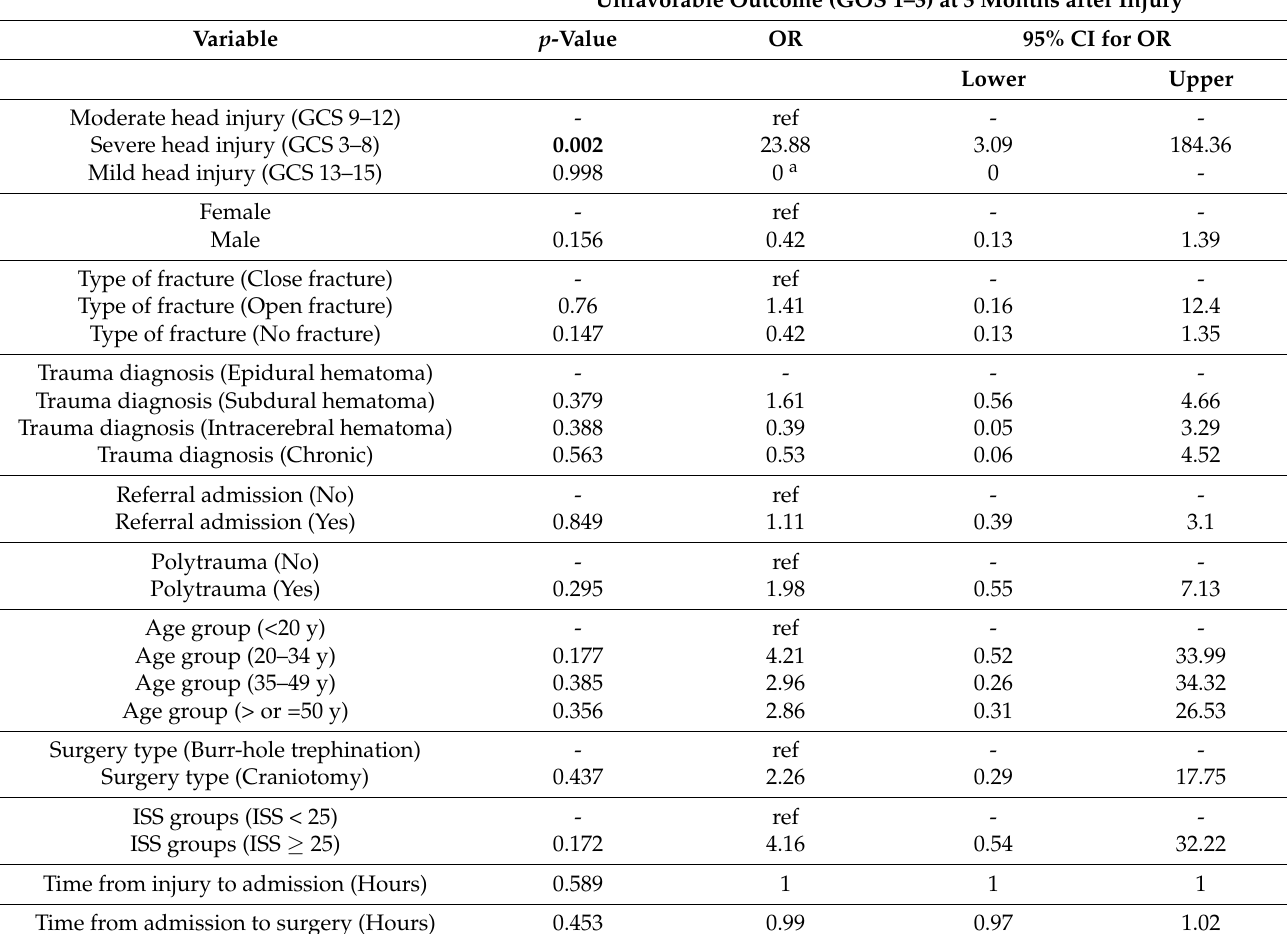
Table 4. The risk of unfavorable outcome three months after injury: univariate analysis by binary logistic